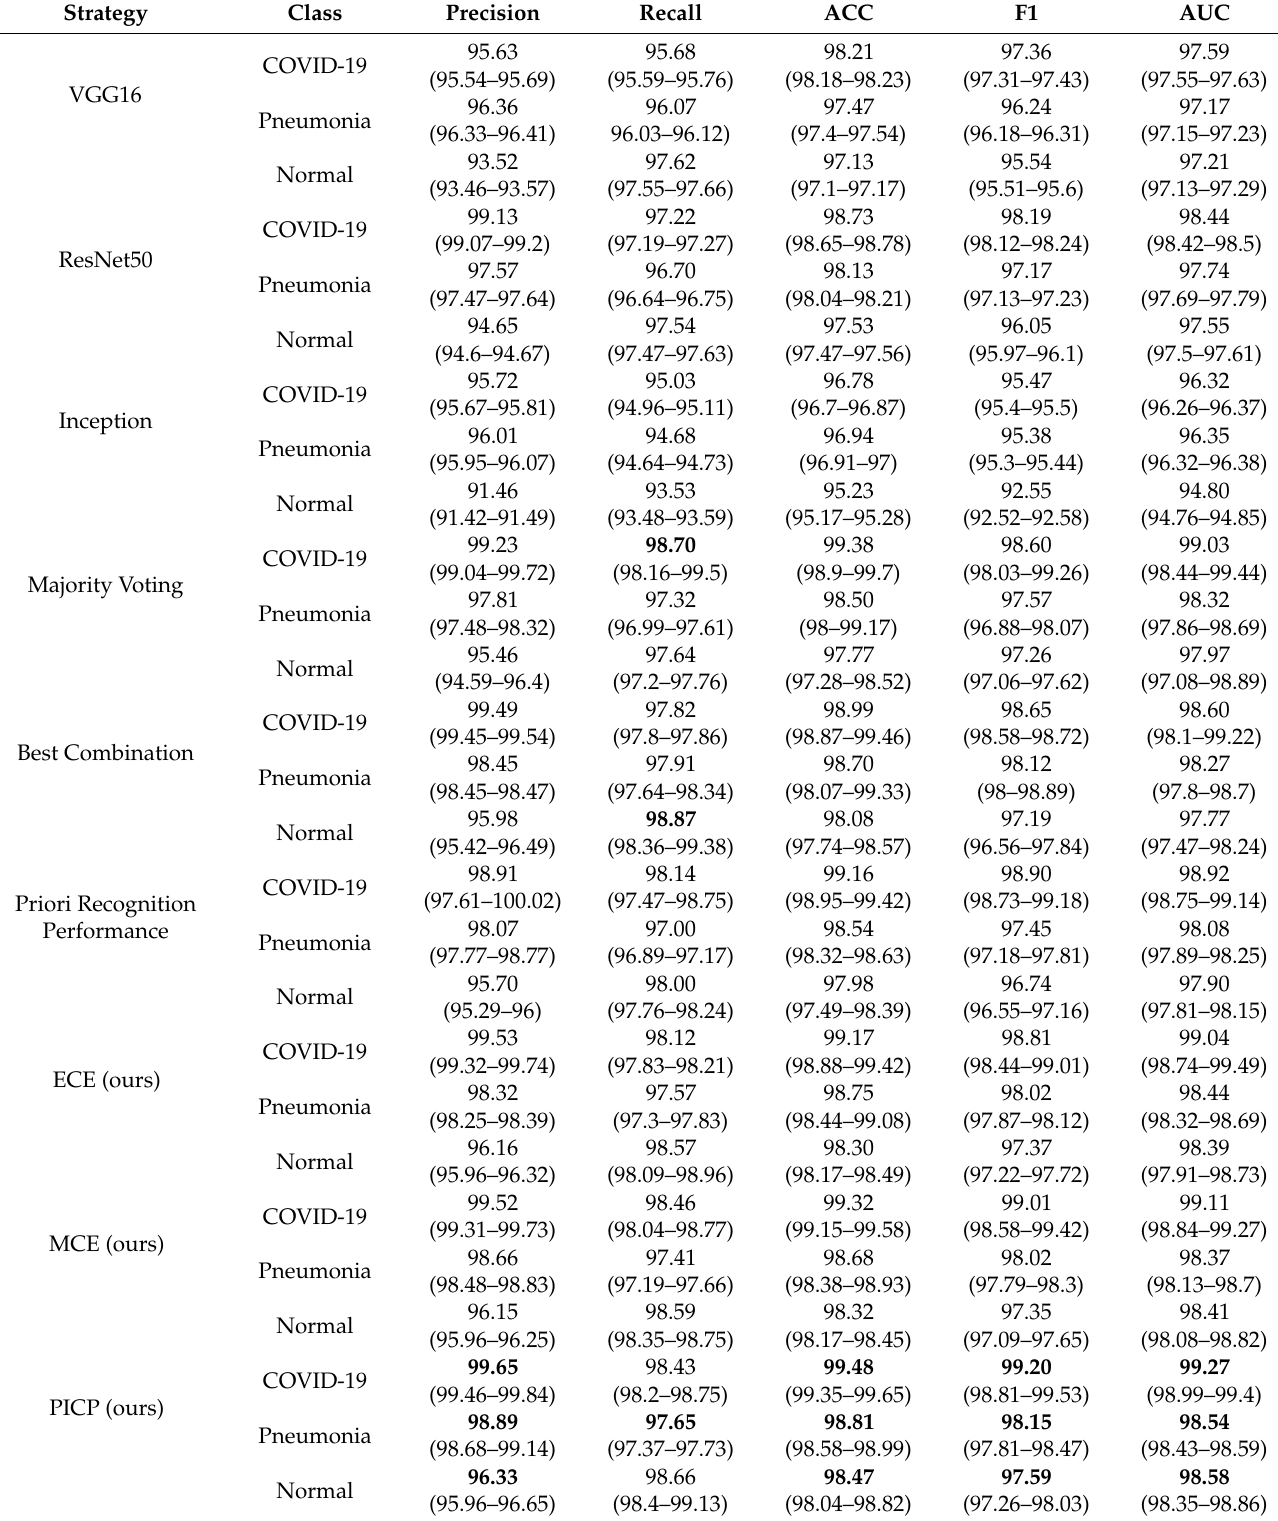
Table 5. Performance of the ensembled models per